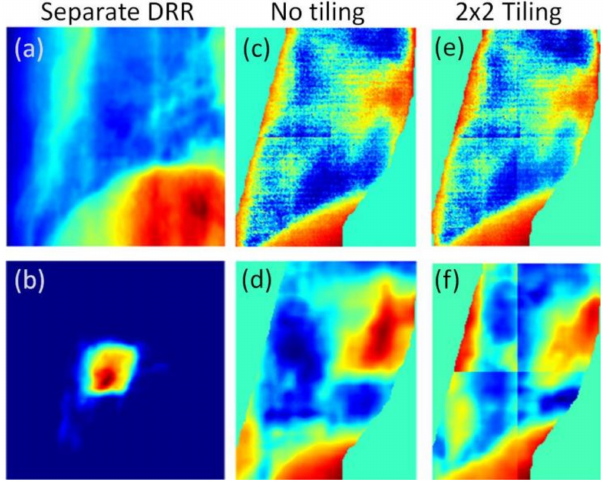
Figure 3. Sample of digitally reconstructed radiographs (DRR) matching and tiling results. ( a ) DRR of the background; ( b ) DRR of the tumor; ( c ) acquired megavoltage (MV) projection; ( d ) composite DRR without tiling; ( e ) MV projection with 2 × 2 titling (two rows and two columns); ( f ) composite DRR with 2 × 2 tiling (two rows and two columns). All four tiles were normalized individually so that their average intensities were zero. The widow level of the upper left tile changed significantly, much closer to the corresponding tile in ( e ), and better similarity was observed for the upper left tiles using tiling-based matching than using global matching between ( c , d